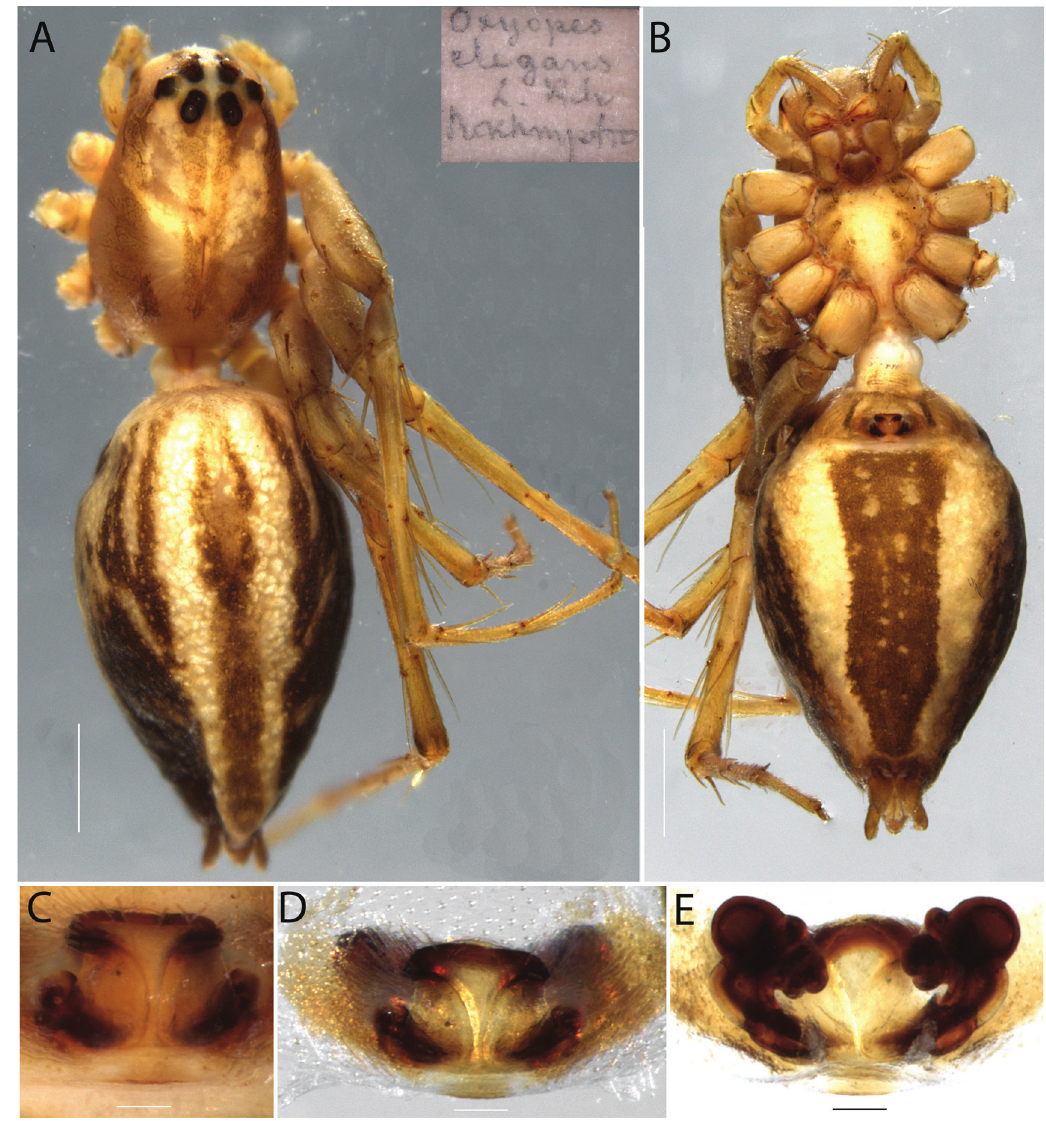
Figure 7. Oxyopes godeffroyi sp. n., female holotype ( ZMH- A0000008): A , habitus, dorsal view; B , habitus, ventral view; C , epigyne, ventral view; D, epigyne, ventral view, cleared; E , epigyne, dorsal view, cleared. Scale bars: habitus 1.0 mm, epigyne 0.1